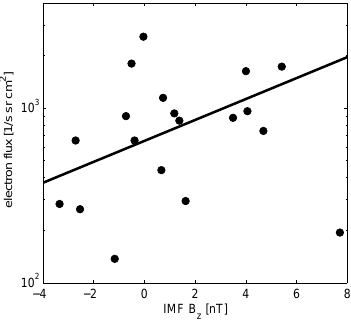
Fig. 5. Total electron fluxes observed in the exterior cusp as a func- tion of IMF B z